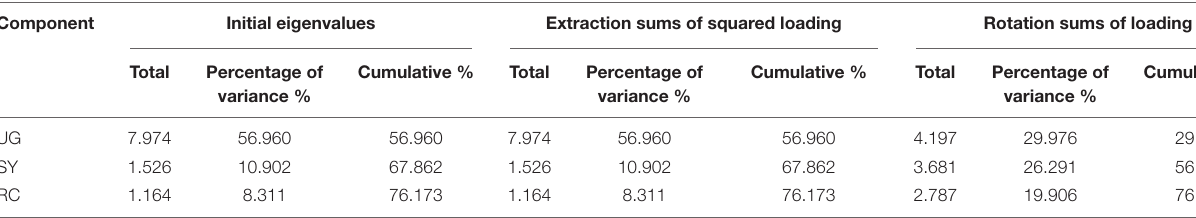
TABLE 5 | Total variance